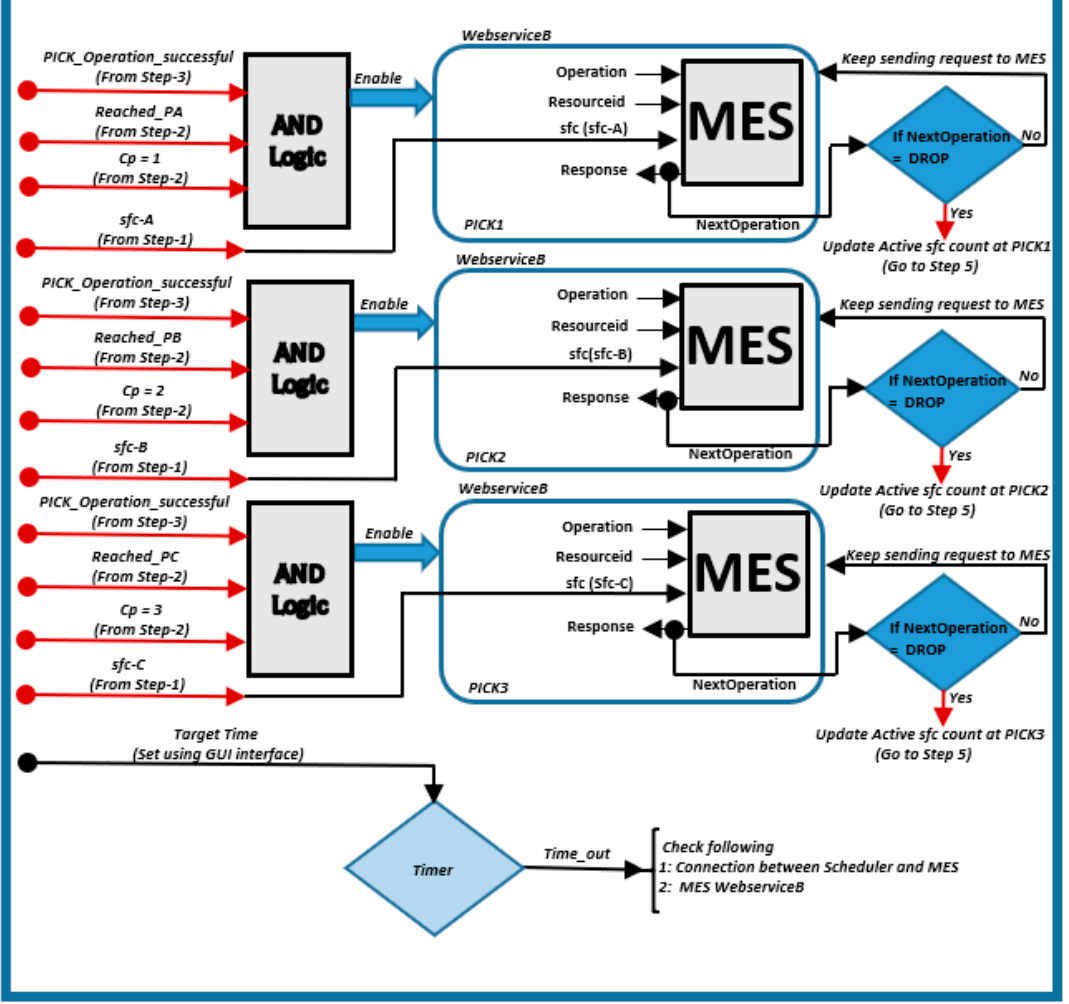
Figure 13. Send Product ‐ Pick confirmation to MES.